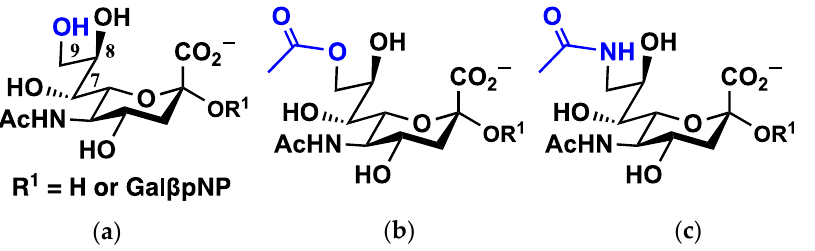
Figure 1. Structures of N -acetylneuraminic acid (Neu5Ac) and analogues, the simulated ligands in this study. ( a ) Neu5Ac; ( b ) Neu5,9Ac 2 ; and ( c ) Neu5Ac9NAc are simulated ligands, corresponding to the unsubstituted Neu5Ac and its 9-OAc and 9-NAc forms. Two substitutions at R 1 were simulated, corresponding to the Sia monosaccharide or an α 2-3-linked sialoside containing the terminal disaccharide of the GM3 ganglioside, commonly found on cell membranes, followed by para -nitrophenol ( p NP), a molecule used in quantifying Sia binding and cleavage in sialidase activity assays.